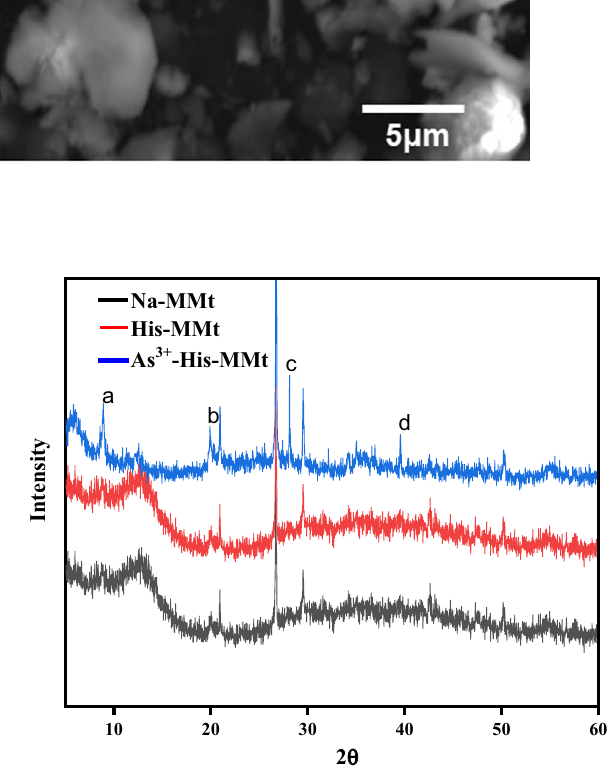
Fig. 4 TGA of Na-MMt and His-MMt